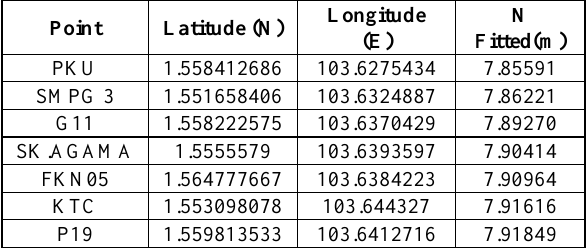
Table 9. Value of positions and N fitted for external accuracy points.